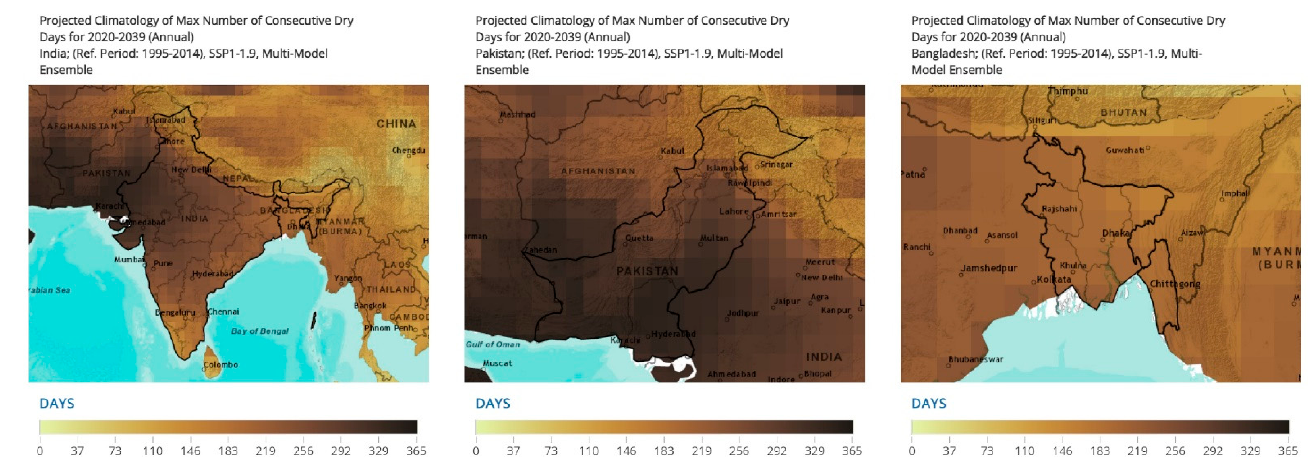
Figure 10. Projected climatology of the maximum number of consecutive dry days for 2020–2039 [49]. Annual projections for the years 2020–2039 are made for the maximum number of consecutive dry days. A reference period of 1995–2014 was utilized. The SSP1-1.9, multi-model ensemble was utilized. The projections are scaled for 365 days as depicted in the figure.